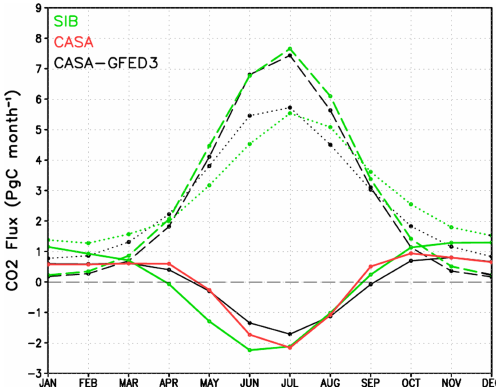
Fig. 7. Seasonal cycles of NEE (solid), gross primary production (GPP, dashed, positive represents influx into the plant canopy), and ecosystem respiration (RE, dotted, positive represents influx into the atmosphere) aggregated from 30–75 ◦ N and averaged from 2006– 2010. Flux estimates are for SIB (green), CASA (red, NEE only) and CASA-GFED3 (black). The timing and magnitude of GPP is approximately the same for both models, which means the differ- ence in the timing of drawdown is likely due to RE, which is de- layed by roughly one month in SIB relative to